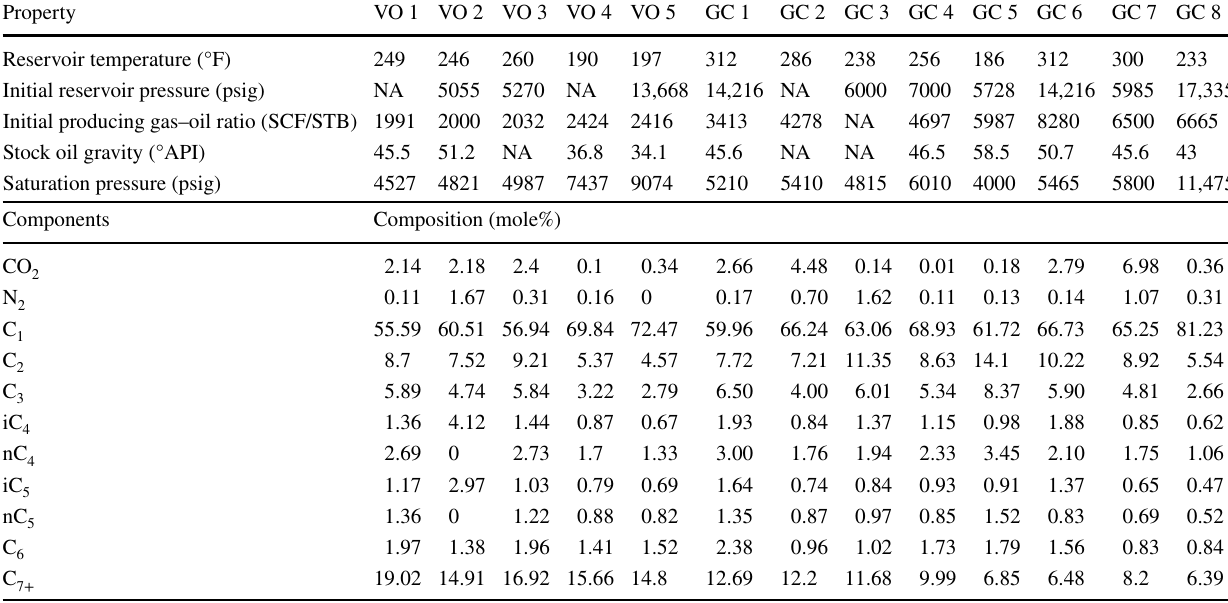
Table 1 Characteristics of fluid samples (Fattah et al. 2009)